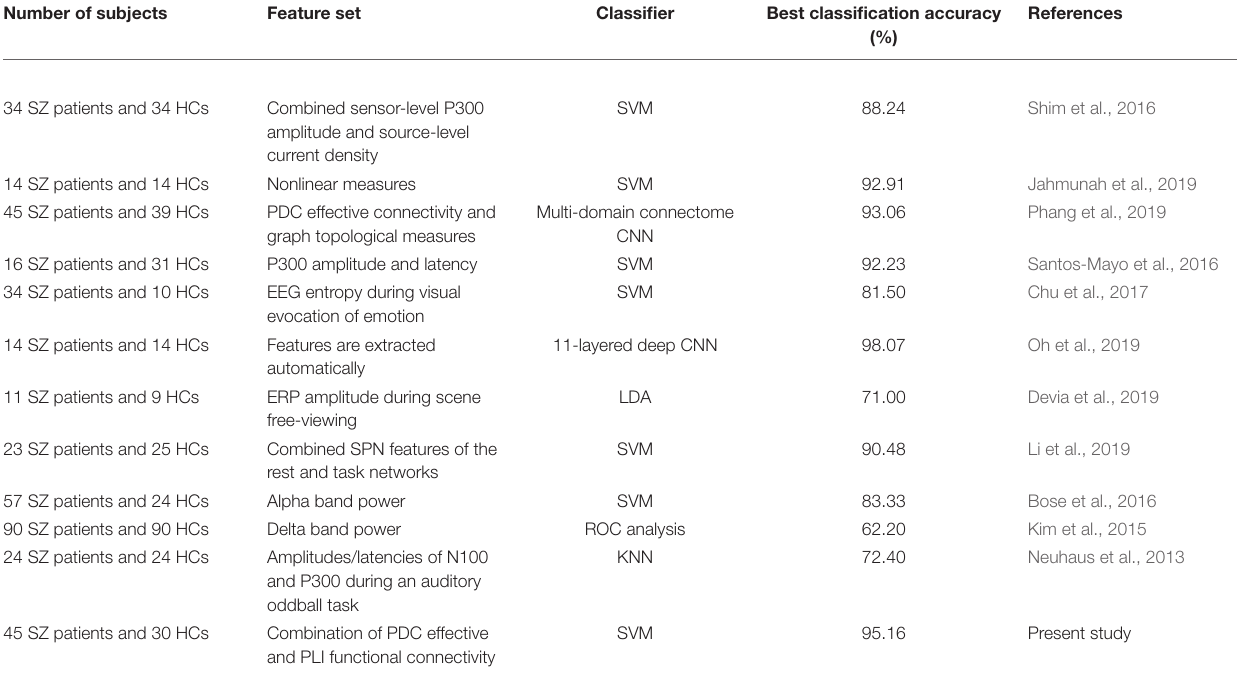
TABLE 3 | Comparison of the classification accuracy of SZ patients with other previous studies. Number of